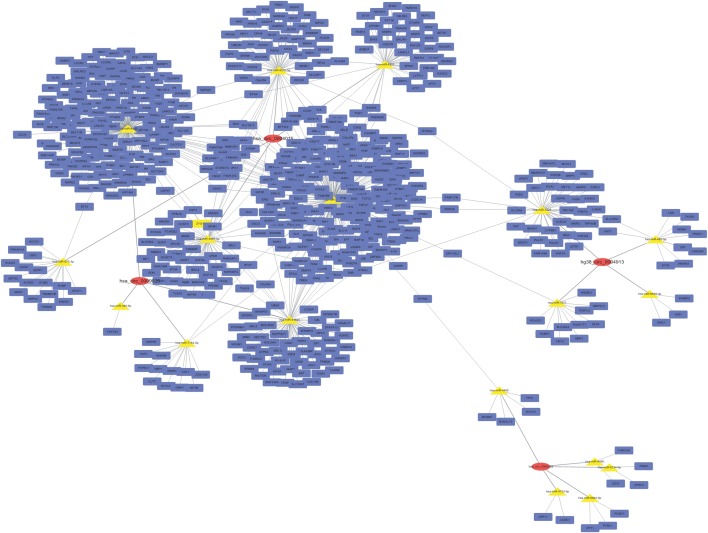
CircRNA–miRNA–target gene interaction network.The top four down- and up-regulated circRNAs were used to construct this network using Cytoscape. Putative interactions between miRNAs and circRNAs were evaluated using miRanda. The top five (highest targeting relationship score) miRNAs were selected, then the same miRNAs’ target genes were predicted using miRDB. Target scores > 98 were selected. In this figure, rectangles represent mRNAs while ovals represent circRNAs and triangles represent miRNAs.